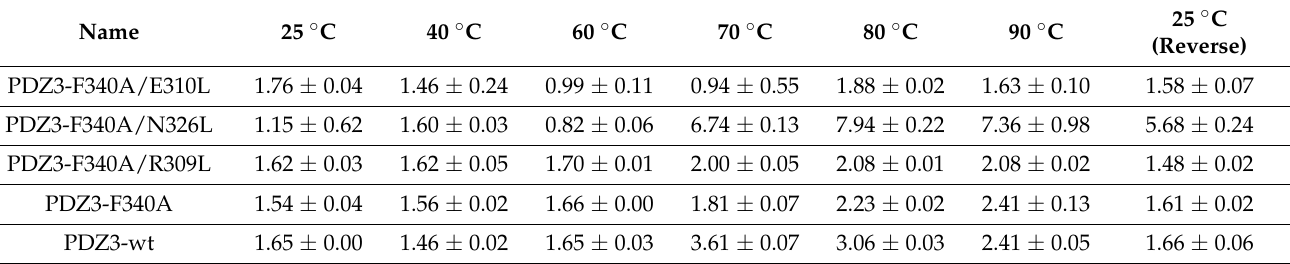
Table 4. Hydrodynamic radius (nm, R h ) by